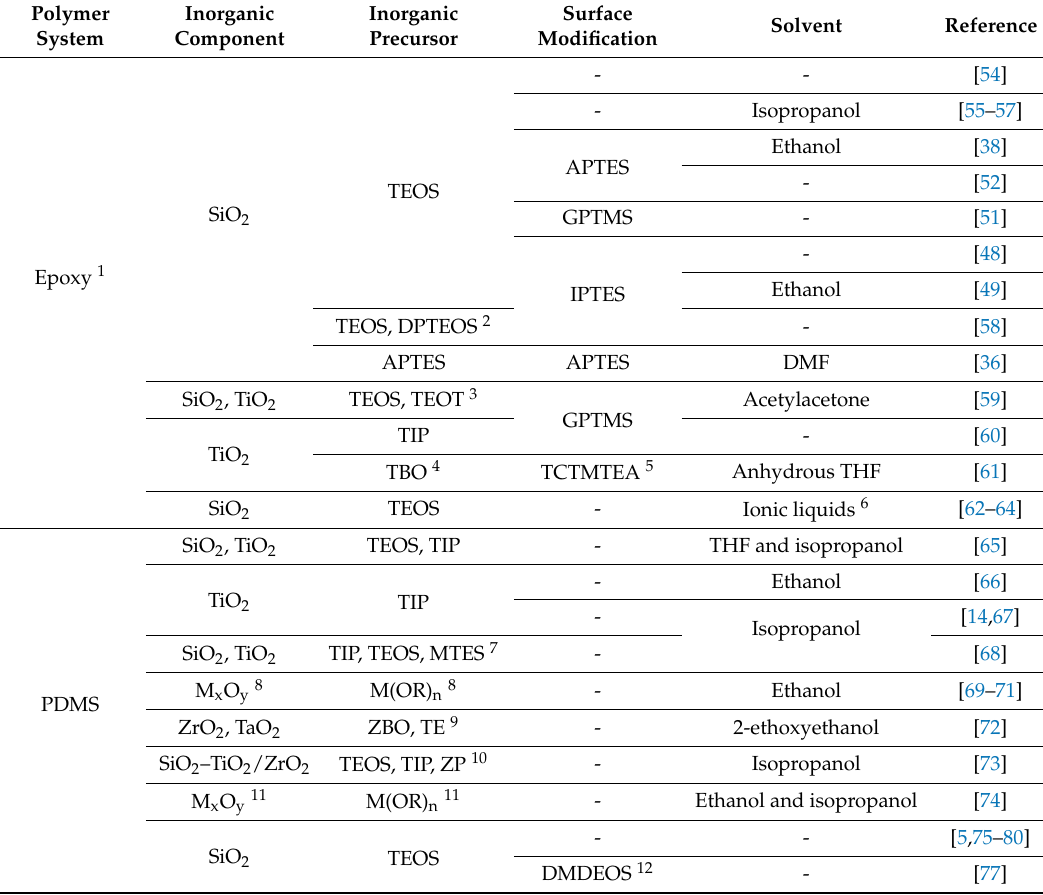
Table 1. Selected examples of the precursors, surface modification and solvents used in the in situ synthesis of metal oxide nanoparticles via sol–gel processes in epoxy and polydimethylsiloxane (PDMS)